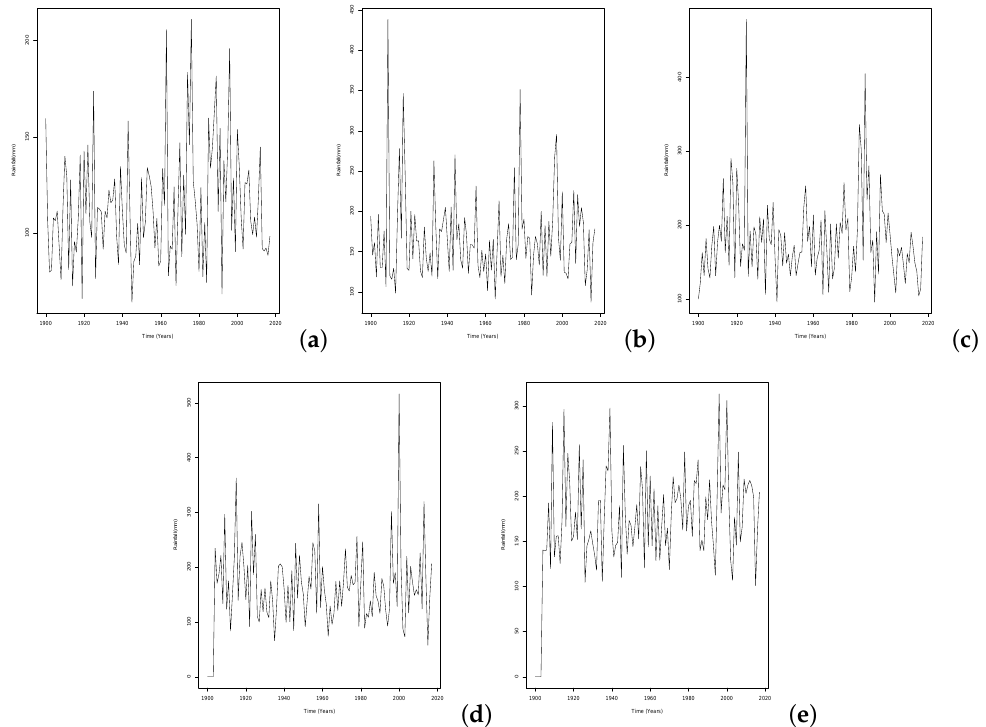
Figure 2. Time series plot of the annual block maximum rainfall observed in ( a ) Eastern Cape 1900–2017, ( b ) Gauteng 1900–2017, ( c ) KwaZulu-Natal 1900–2017, ( d ) Limpopo 1904–2017